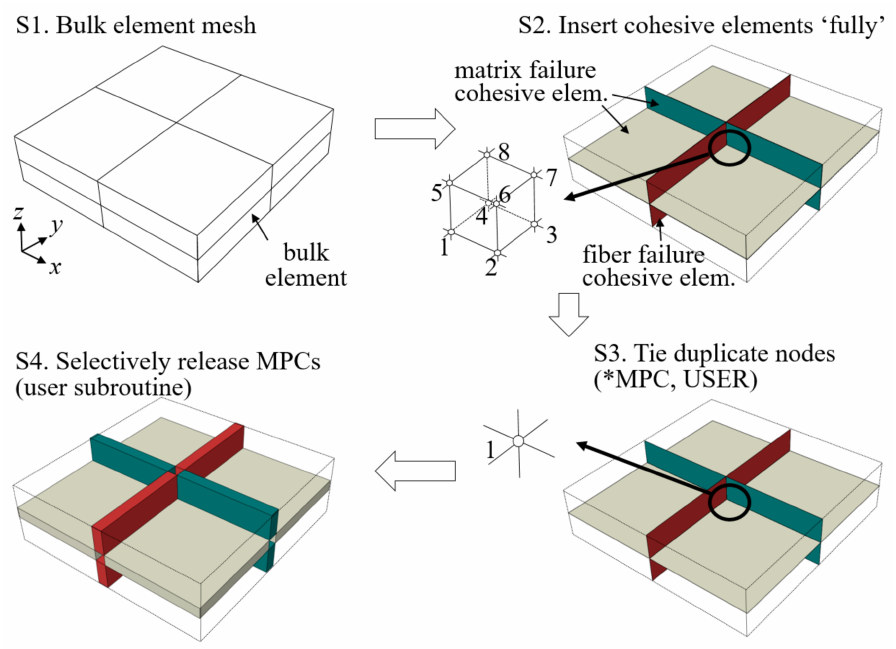
Figure 7. Schematic of MCZM